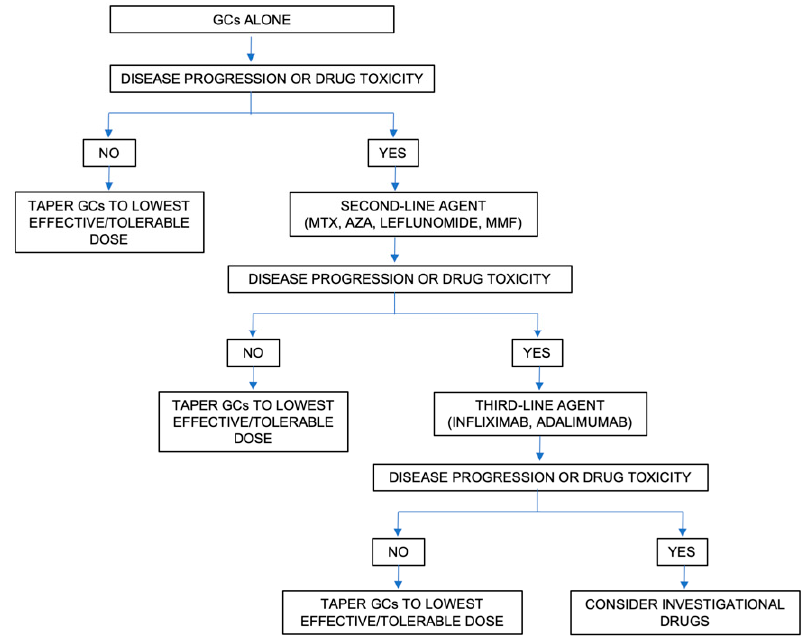
Figure 5. Approach to the therapeutic management of sarcoidosis. Abbreviations: AZA: azathioprine; GCs: glucocorticoids; MMF: mycophenolate mofetil; MTX: methotrexate.